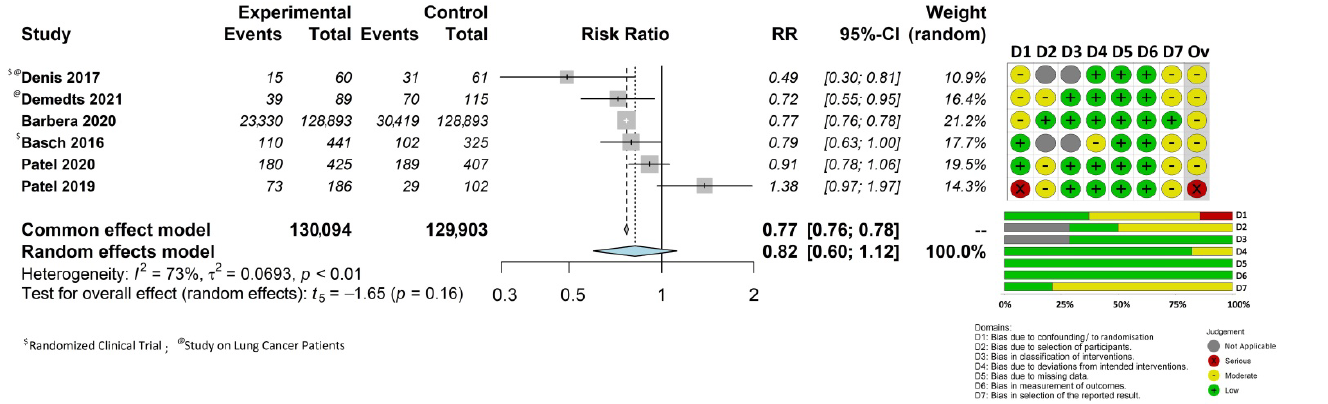
Figure 2. A forest plot of the survival pooled effect and a summary of the risk of bias (traffic light plot and summary bar plot).